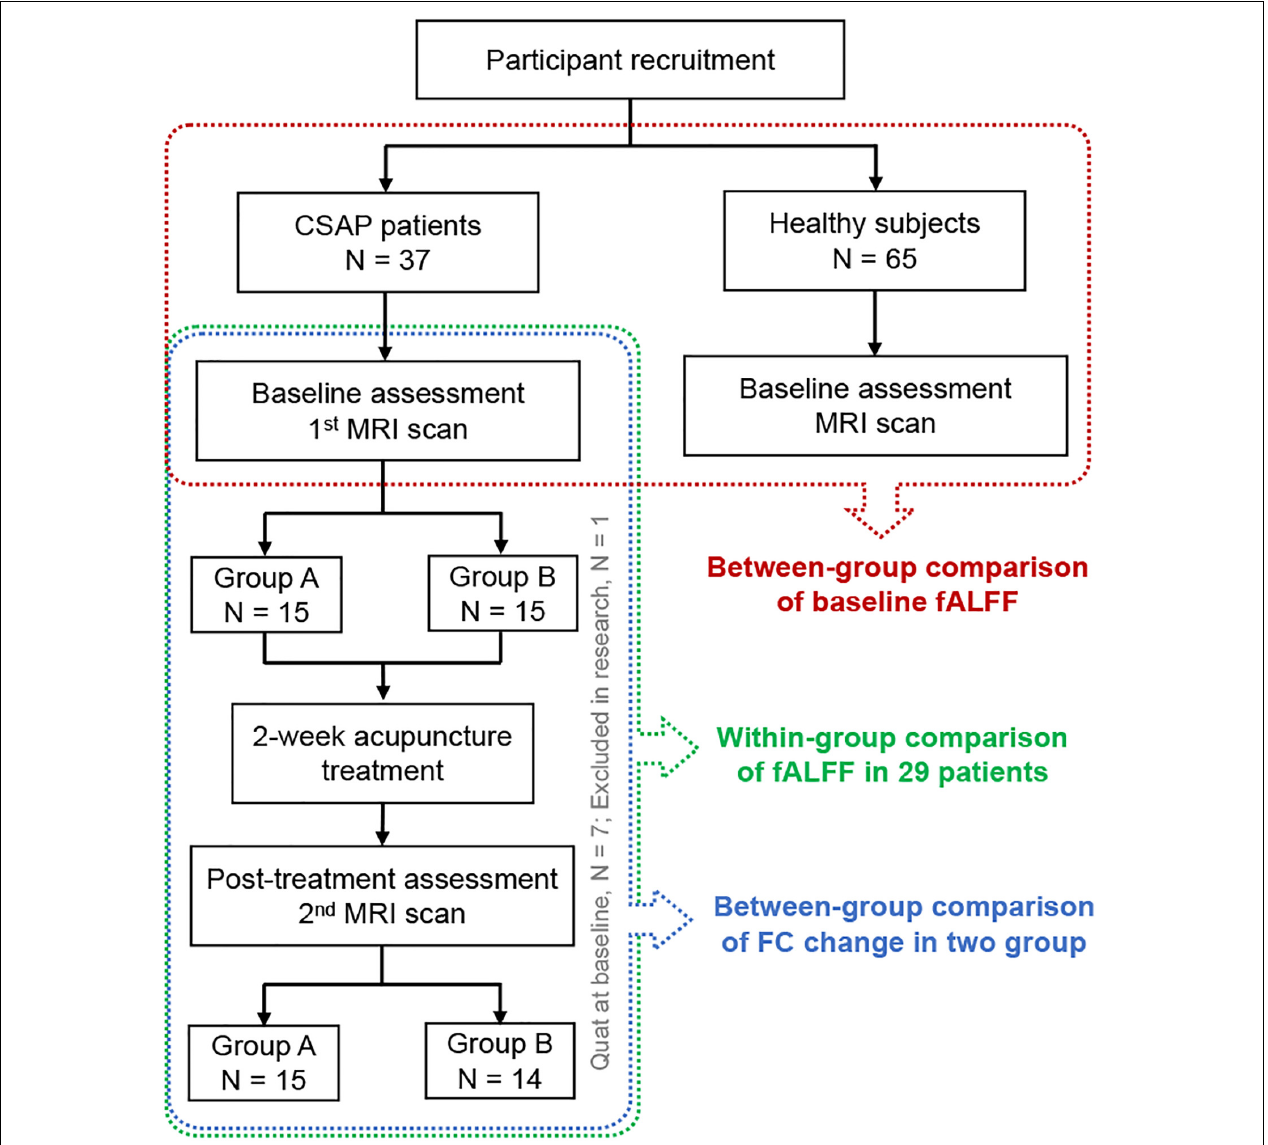
FIGURE 1 | The flowchart of the study. CSAP, chronic stable angina pectoris; MRI, Magnetic Resonance Imaging; fALFF, fractional Amplitude of Low-Frequency Fluctuation; FC, functional